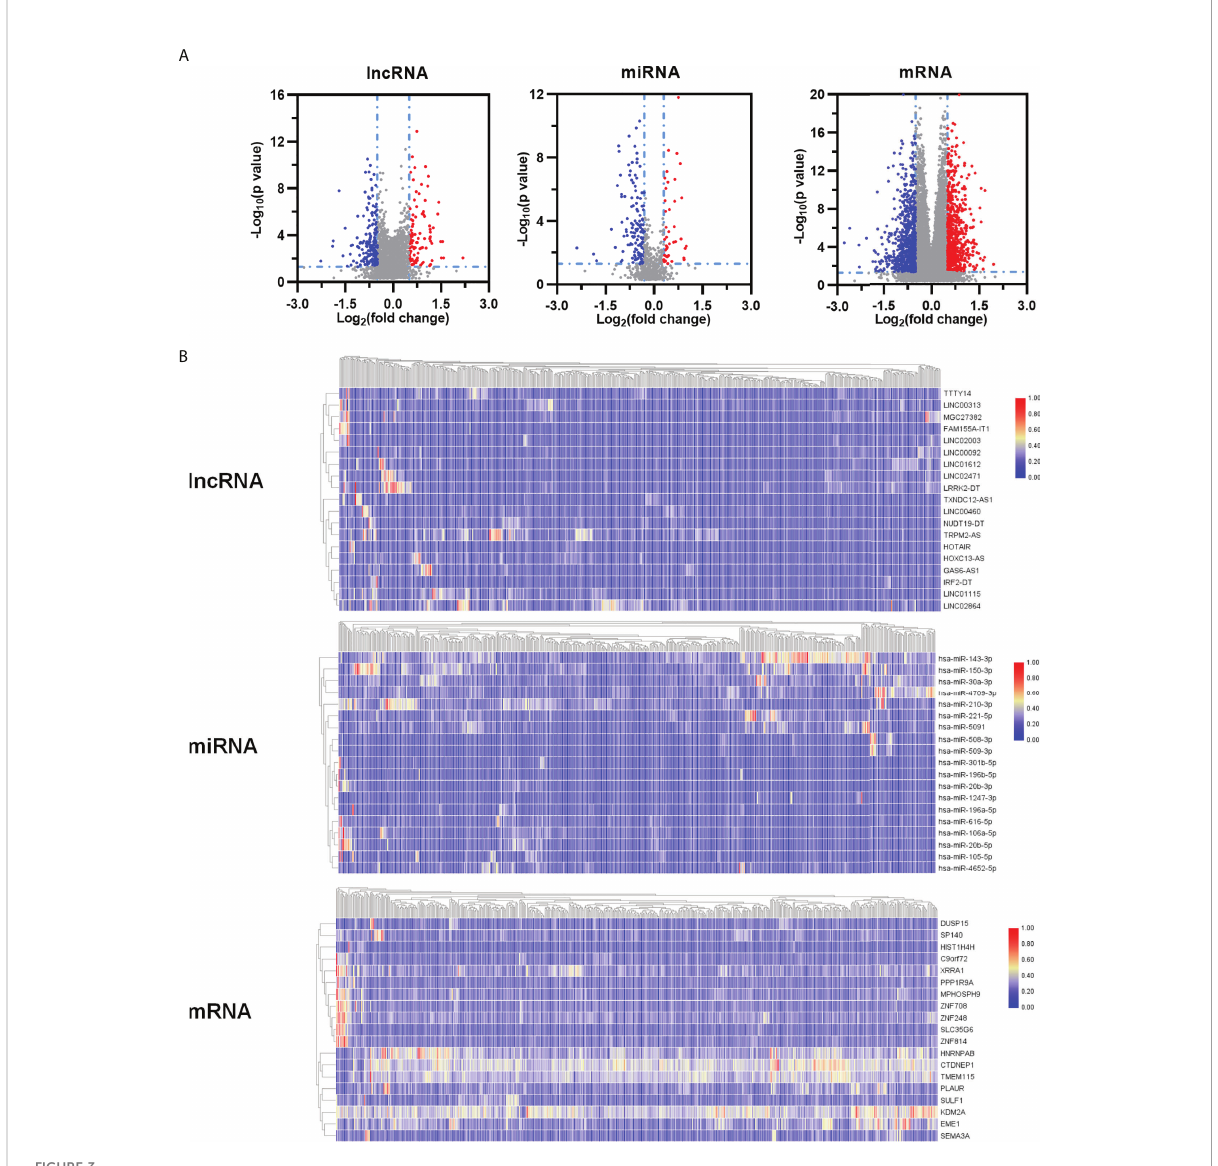
Figure S3, S4, the expression of LINC00460/EME1/HNRNPAB/ PLAUR and SEMA3A was higher in most tumour tissues, including LUAD, than in the corresponding control tissues (P < 0.001). However, the expression of mir-150-3p was lower in most pan-cancer tissues (P <